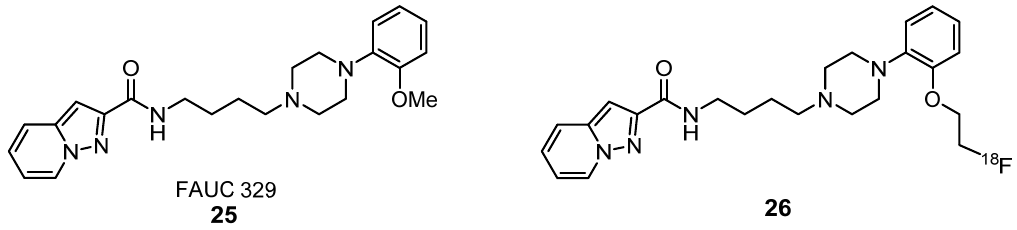
Figure 10. Radiotracer 26 derived from the dopamine D 3 receptor ligand FAUC 329 ( 25 ) [53].